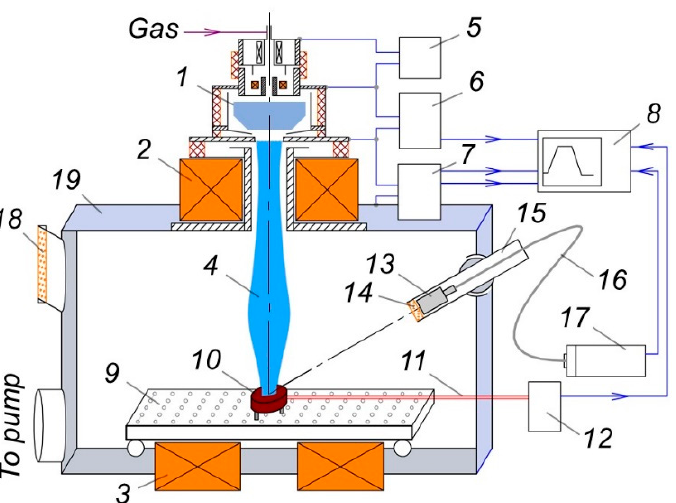
Figure 1. Schematic diagram of the experimental setup: 1 —SOLO electron source, 2 , 3 —magnetic coils, 4 —electron beam, 5 —auxiliary discharge power supply, 6 —plasma cathode discharge power supply, 7 —accelerating voltage power supply, 8 —oscilloscope, 9 —manipulator table, 10 —thermally insulated sample, 11 —thermocouple, 12 —normalizing converter, 13 —lens, 14 —quartz glass, 15 — rotary joint, 16 —fiber-optic cable, 17 —high speed pyrometer, 18 —viewing window, and 19 — vacuum chamber.